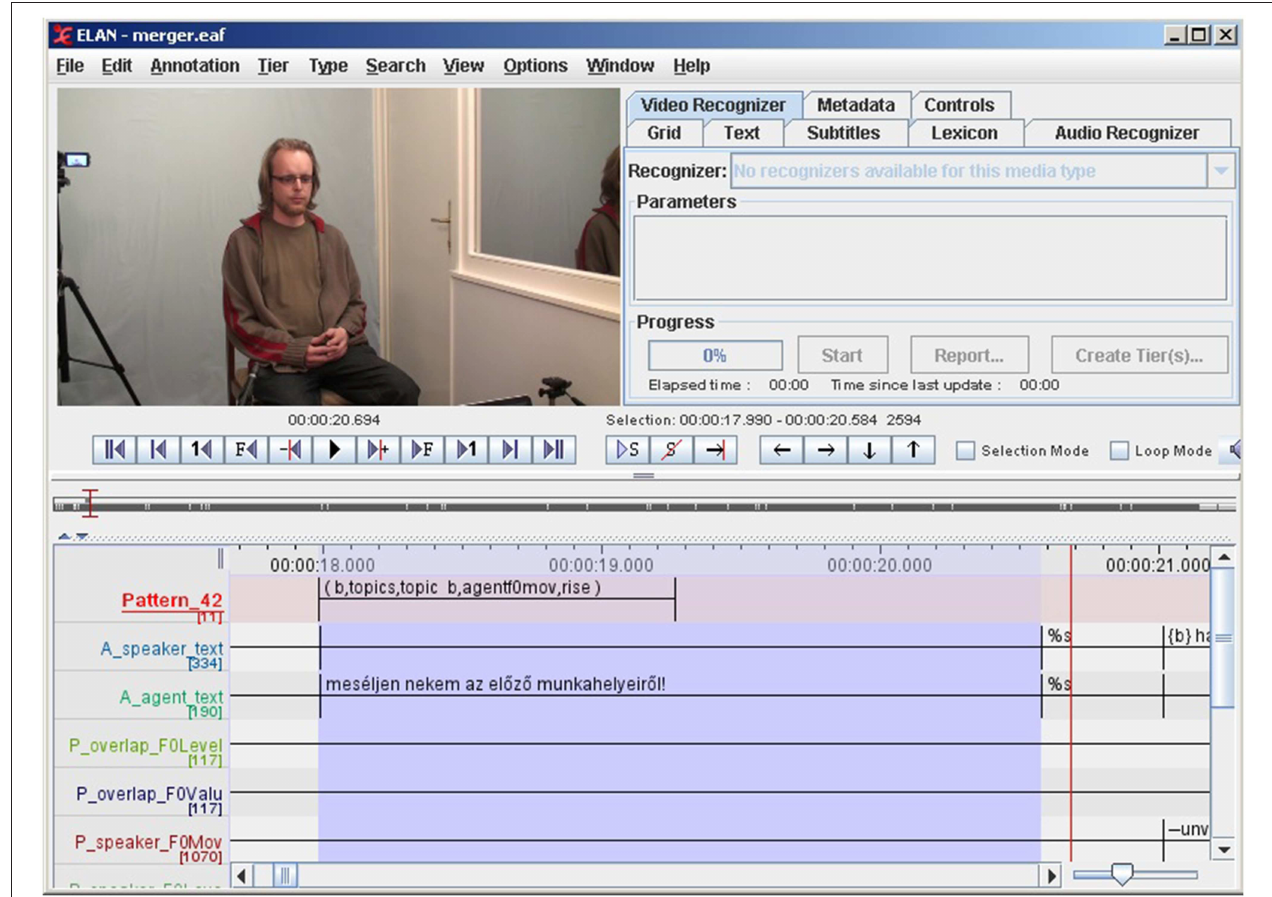
FIGURE 9 | Representing T-patterns in ELAN. In this example, the exported EAF was previously merged with the original annotation file. The first annotation tier displays the instances of Pattern 42 .